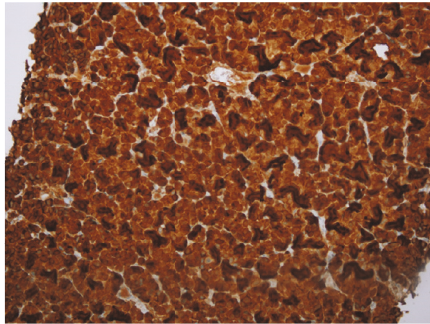
Figure 4: Immunohistochemical examination of the mediastinal mass core needle biopsy using the Prostate Specific Antigen (PSA) stain ( ×